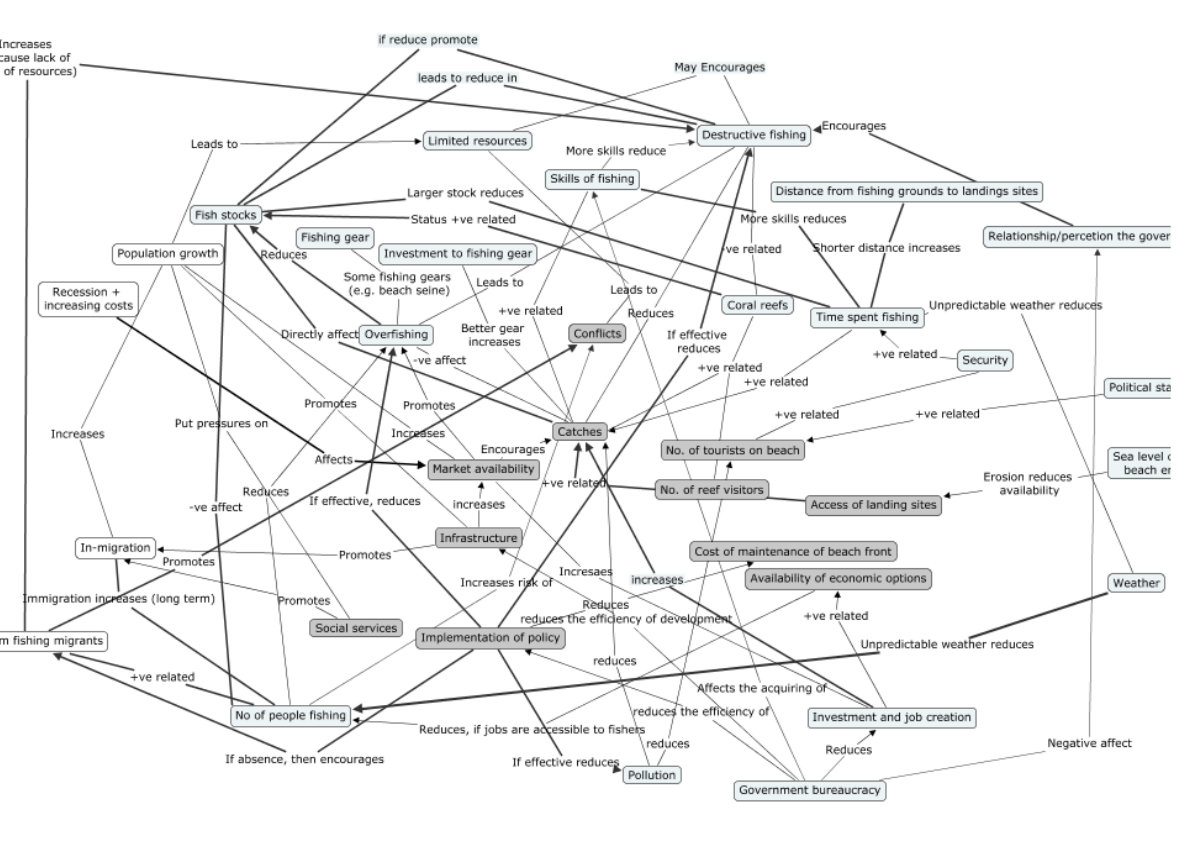
Figure S2. Workshop 1 collective